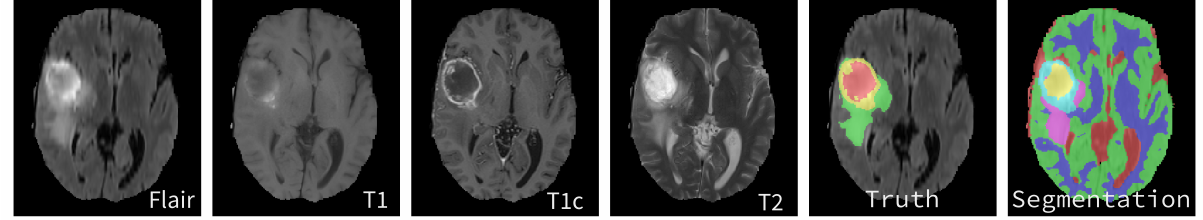
Figure 7. Exemplary multimodal MR images of a high-grade Glioma patient 0001 with truth and label result from an automatic segmentation of a BRATS participant (red=cranio spinal fluid, green=gray matter, blue=white matter, yellow=necrotic, turquoise=active tumor,